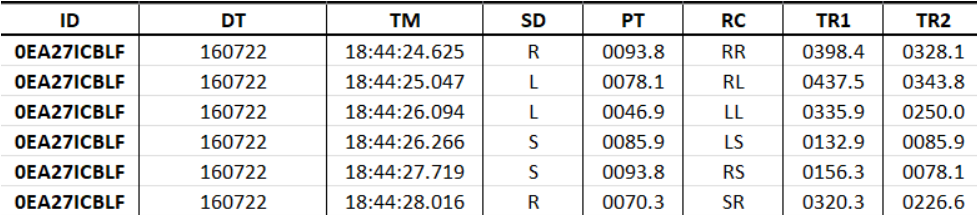
Figure 3. Structure of the used